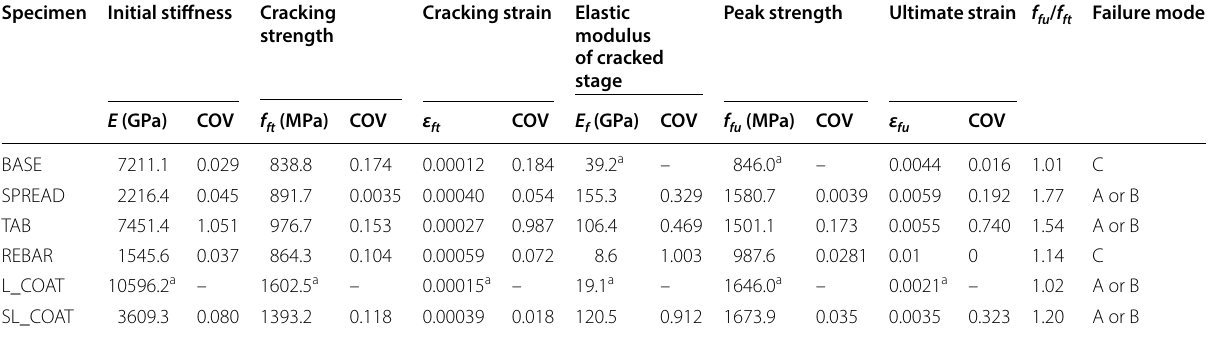
a Test results obtained from only one test